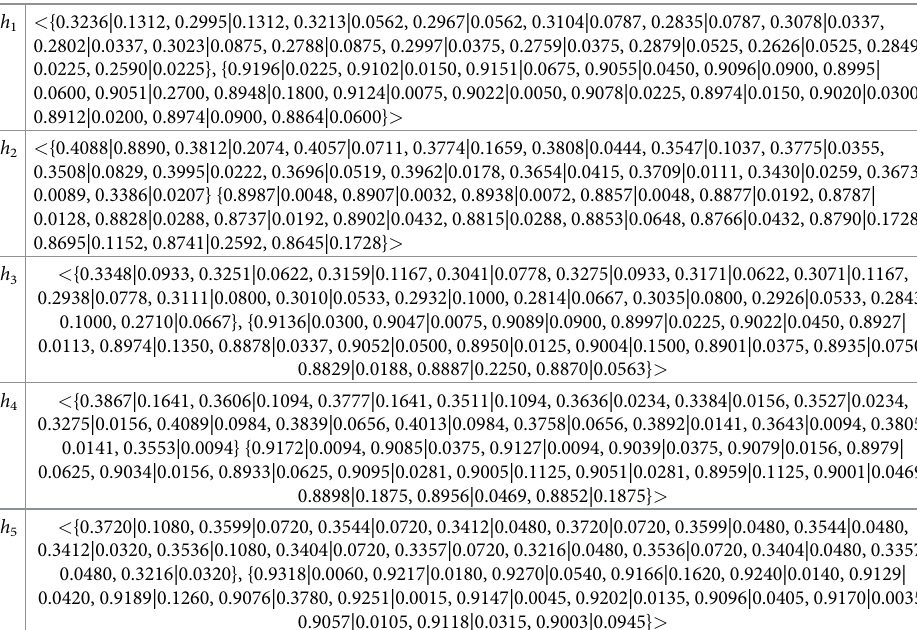
Table 2. The comprehensive evaluation